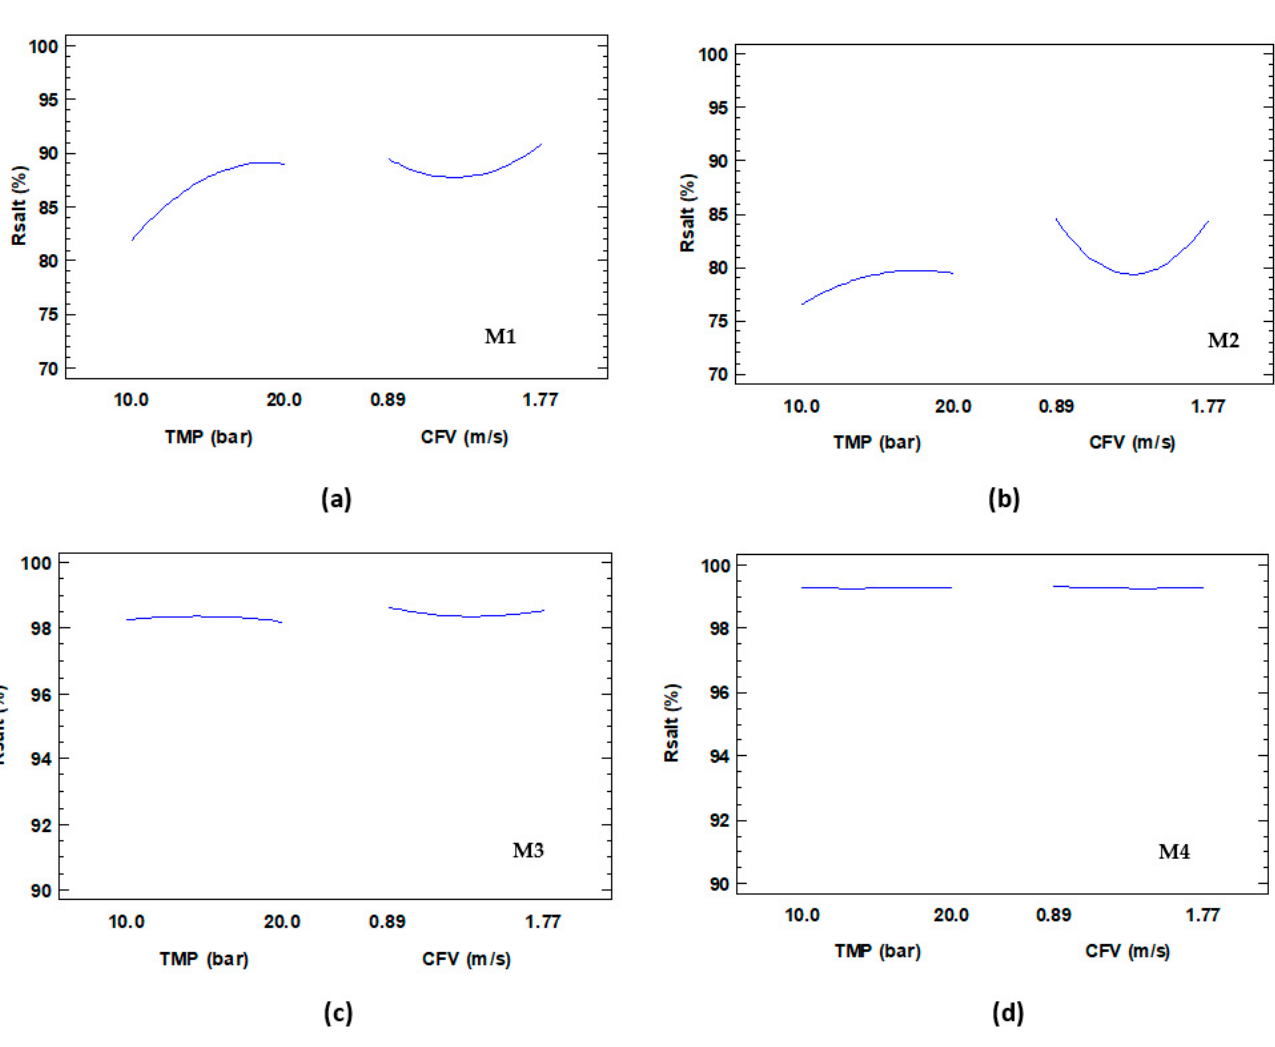
Figure 5. Main effect chart: influence of TMP and CFV on R Salt for ( a ) NF270, ( b ) NF Duraslick, ( c ) RO Duraslick, and ( d ) SWC3.